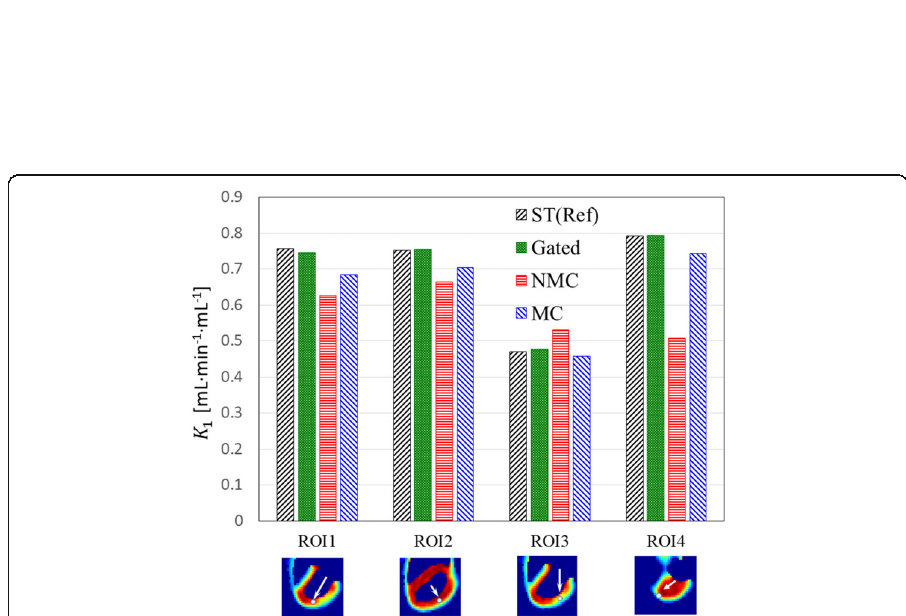
Fig. 7 Mean K 1 values estimated from 25 noise realizations. Each white arrow and a small circle were only used to indicate the approximate location of the ROI. Please see the text in the “ Methods ” section for the details on how the ROIs were